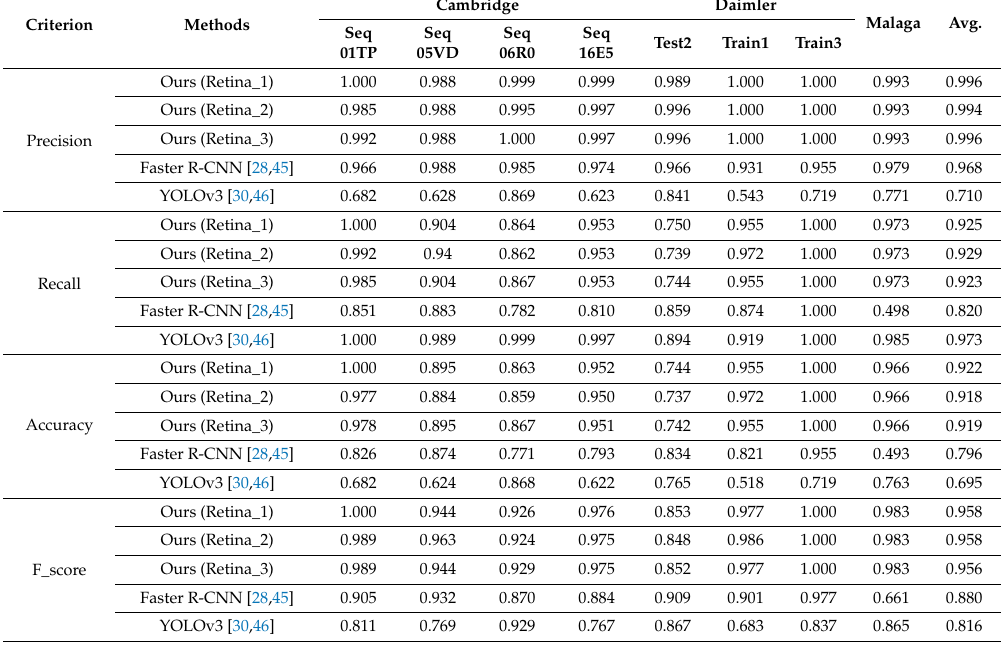
Table 7. Comparisons between proposed method and other methods of different encoders, one-stage and two-stage methods.